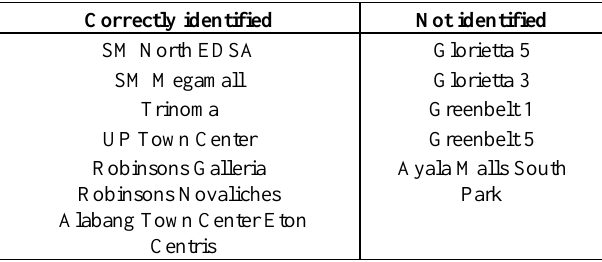
Table 6. Verification of Suitability